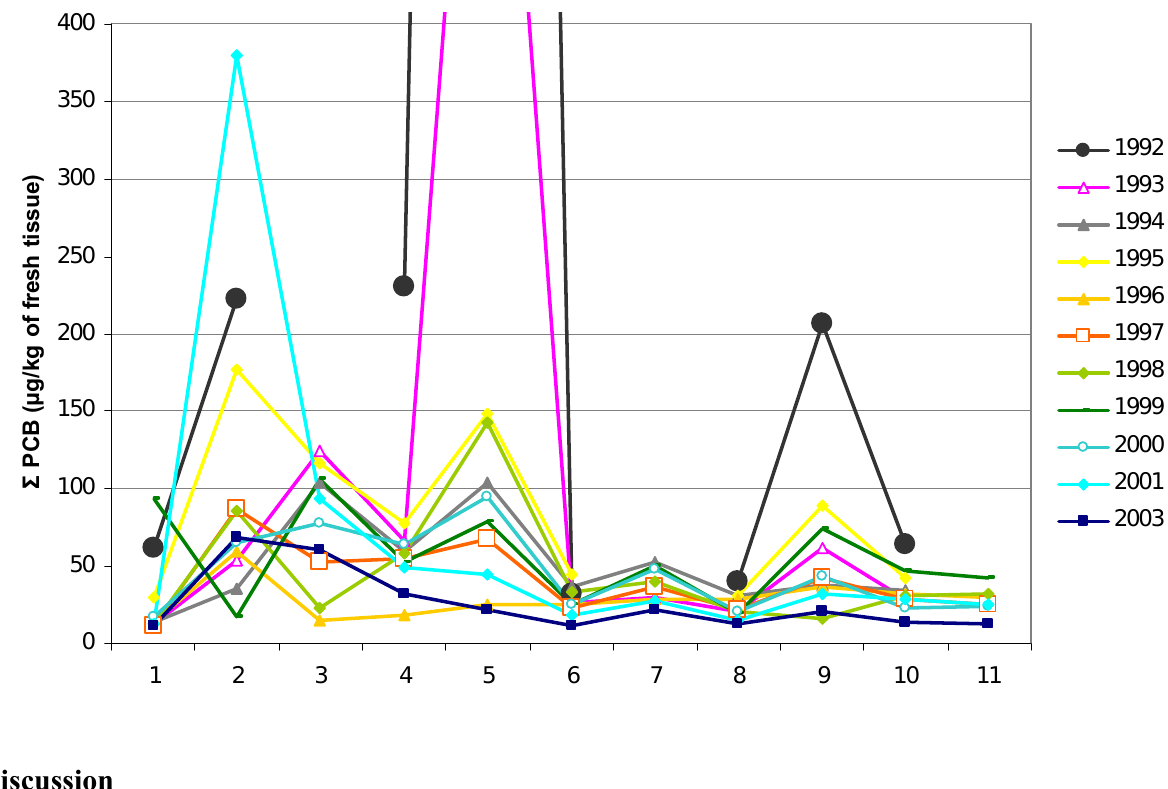
for site codes. ( Σ PCB content at site 5 in 1992 was 2763.0  g.kg -1 in 1993 it was 767.0  g.kg -1